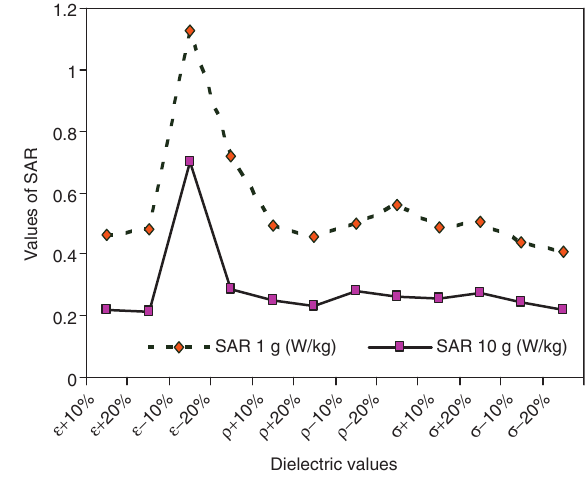
Figure 4 Deviation of the peak of unaveraged SAR in different dielectric properties of Rogers R03006 (loss free) substrate at 2450